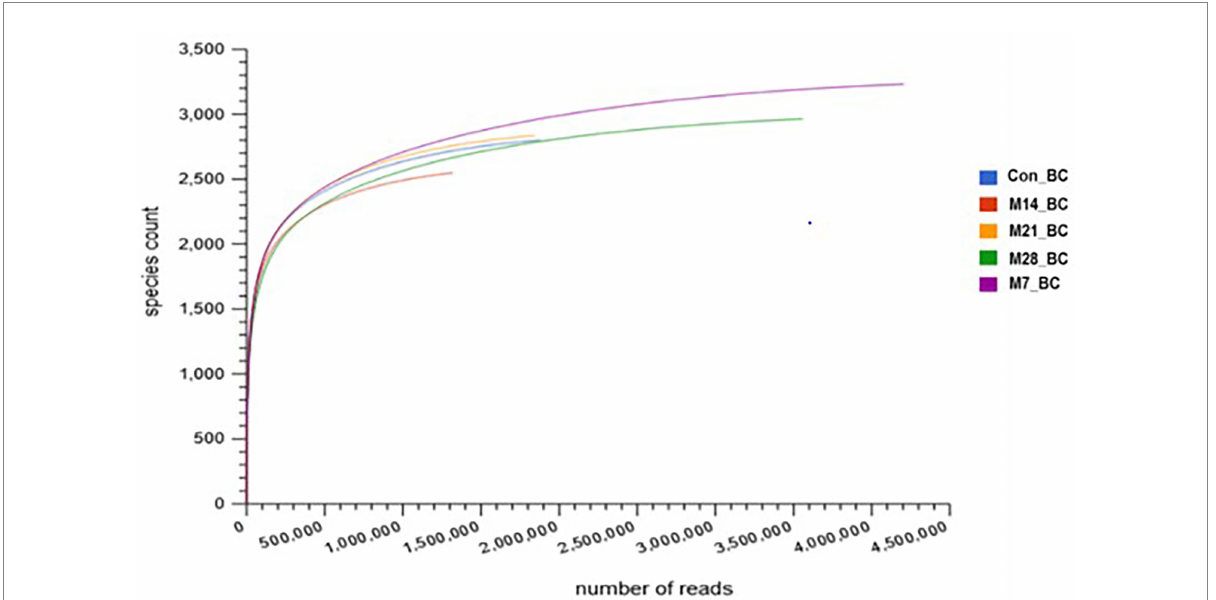
FIGURE 1 Rarefaction curve showing the microbial community richness in caecal digesta from broiler chicken fed with diets containing different levels of marama bean meal [Treatment groups: 0% (Con_BC); 7% (M7_BC); 14% (M14_BC); 21% (M21_BC); 28% (M28_BC) inclusion levels].